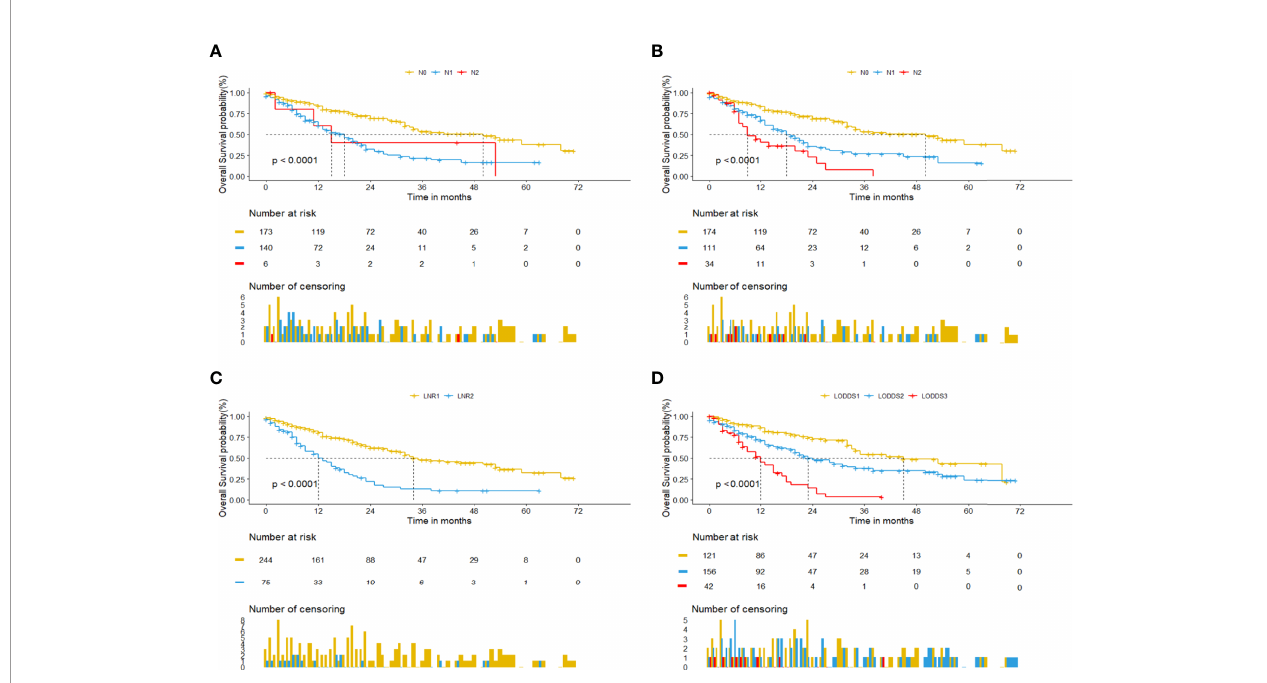
FIGURE 1 | Kaplan-Meier curves for pCCA patients based on four lymph node evaluation factors. (A) 7 th N stage. (B) 8 th N stage. (C) LNR. (D)